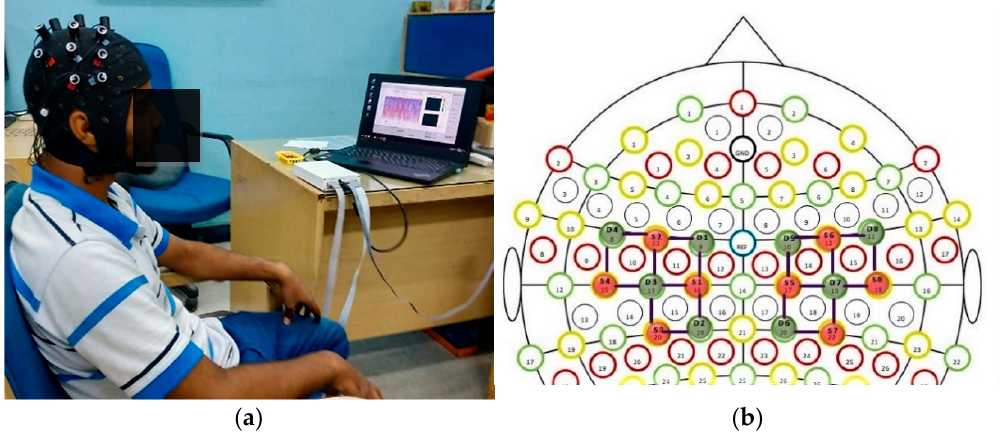
Figure 3. Signal acquisition environment and optode placement. ( a ) Experiment setup showing optode placement on the motor cortex of a healthy subject. ( b ) Eight sources (S) and eight detectors (D) were positioned on the subject’s motor cortex region of the brain to record fNIRS signals with a separation of 3 cm resulting in twenty channels.